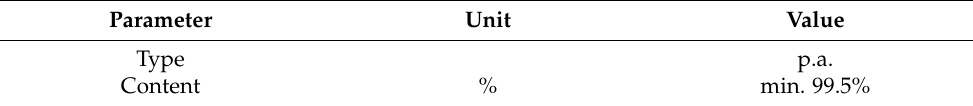
Table 4. Boric acid.